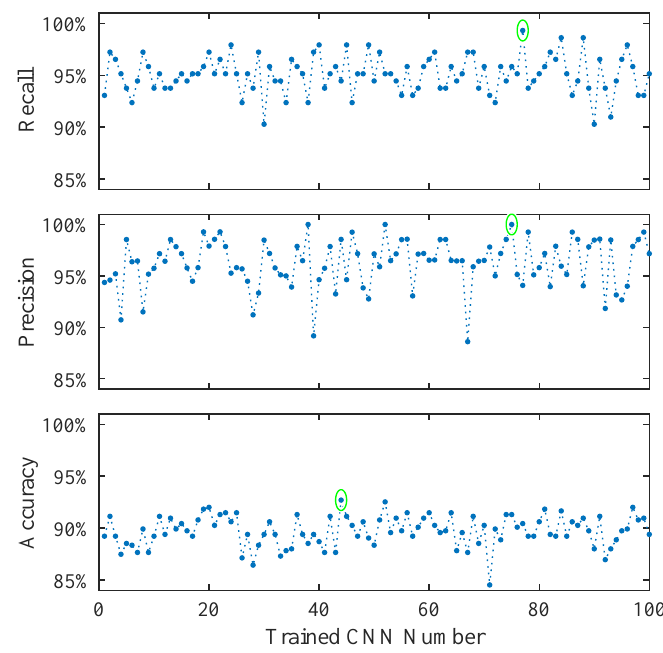
Figure 7. Performances of 100 times trained the simple CNN.